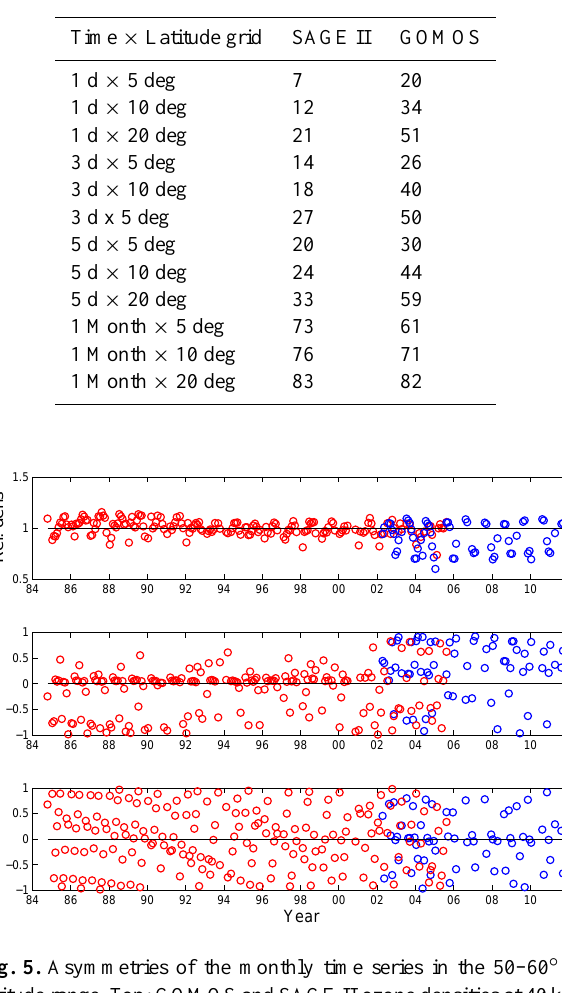
Table 2. SAGE II and GOMOS filling factors for various grids (%).